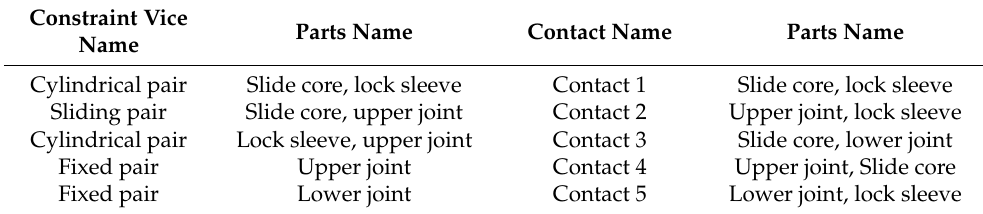
Table 1. The contact of each component and the corresponding constraint pair